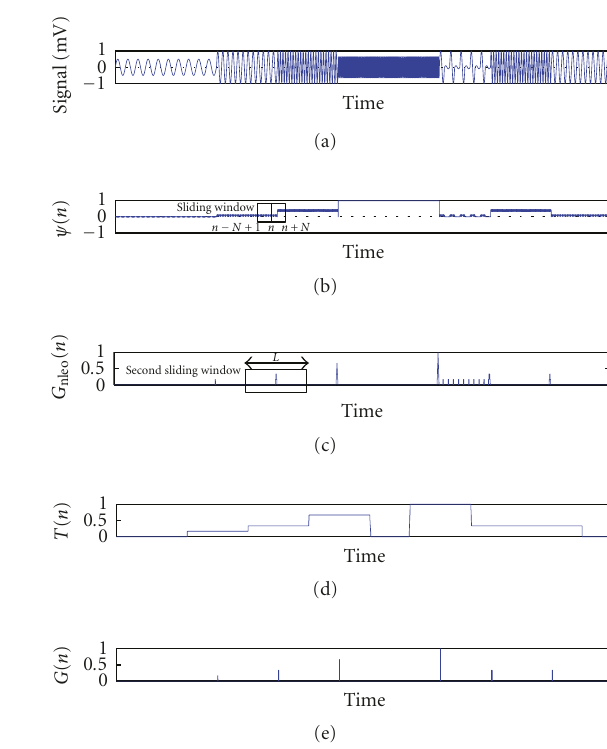
Figure 2: Generation of a trigger from the ECG: illustration on an artificial signal composed of sinusoids with variable amplitudes and frequencies (see main text for details on the signals